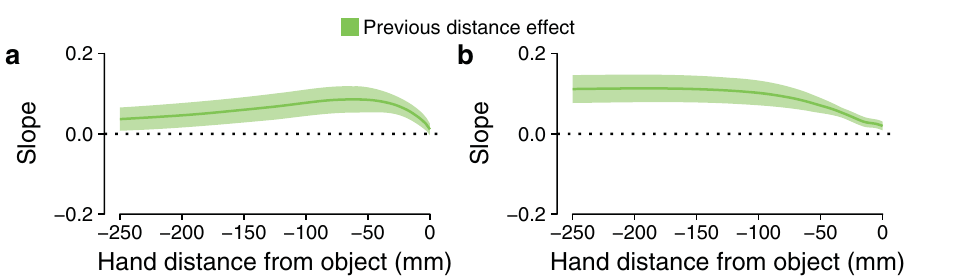
Figure 5. Previous distance effects on the hand position. Slope profiles representing the previous distance effect on the hand position along the movement path when grasping along the depth axis ( a ) and along the oblique axis ( b ). The bands represent the 95% confidence interval of the slope